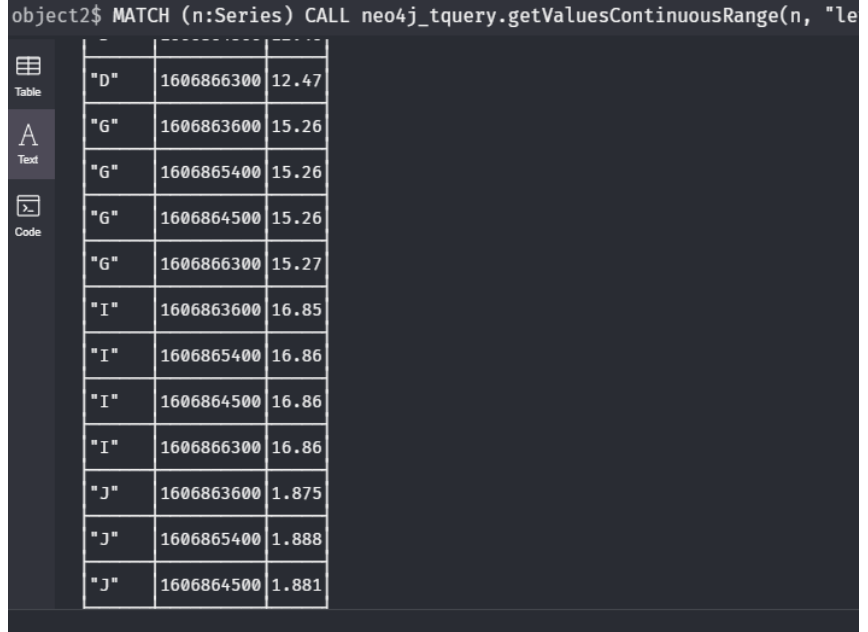
Figure 6. Visualization of the output of query Q 2 run on the sensor network of Figure 4. The result is taken from the web interface of Neo4j. Only a snippet of the entire result is shown. The entire output includes all sensor nodes and for each 4